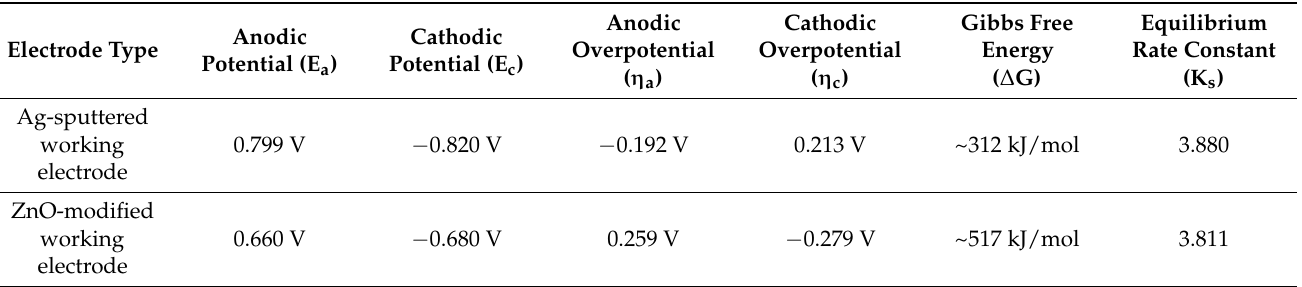
Table 1. Electrochemical parameters calculated for the modified micropipette tips that were used as working